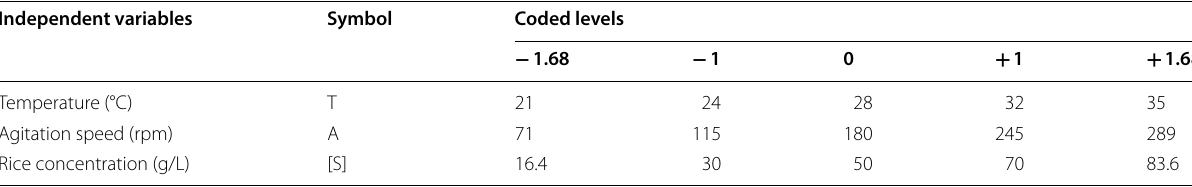
Table 1 Parameters and levels used in the central composite design (CCD) Independent variables Symbol Coded levels